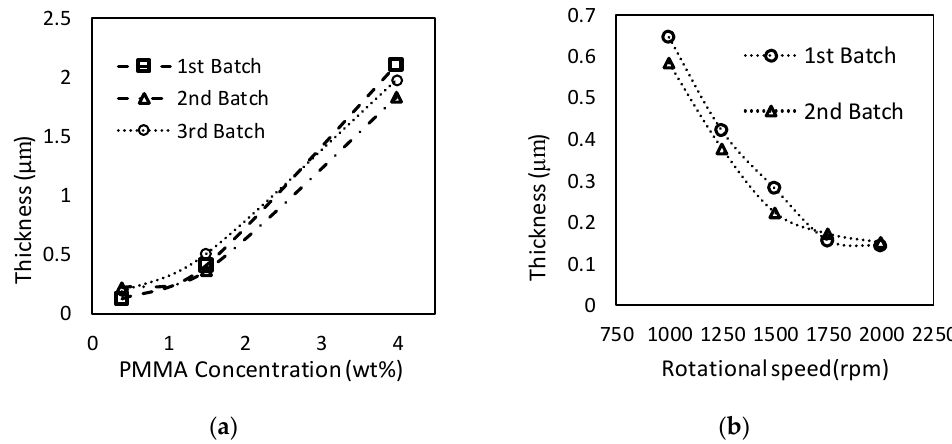
Figure 5. ( a ) Thickness of the PMMA layer as a function of PMMA concentration in anisole (0.4%, 1.5%, and 4%); the coater rotational speed was set to 1750 rpm. ( b ) Thickness of Fluoropel layer for spin coater settings of 1000 rpm, 1250, 1500 rpm, 1750 rpm, and 2000 rpm on Kapton.